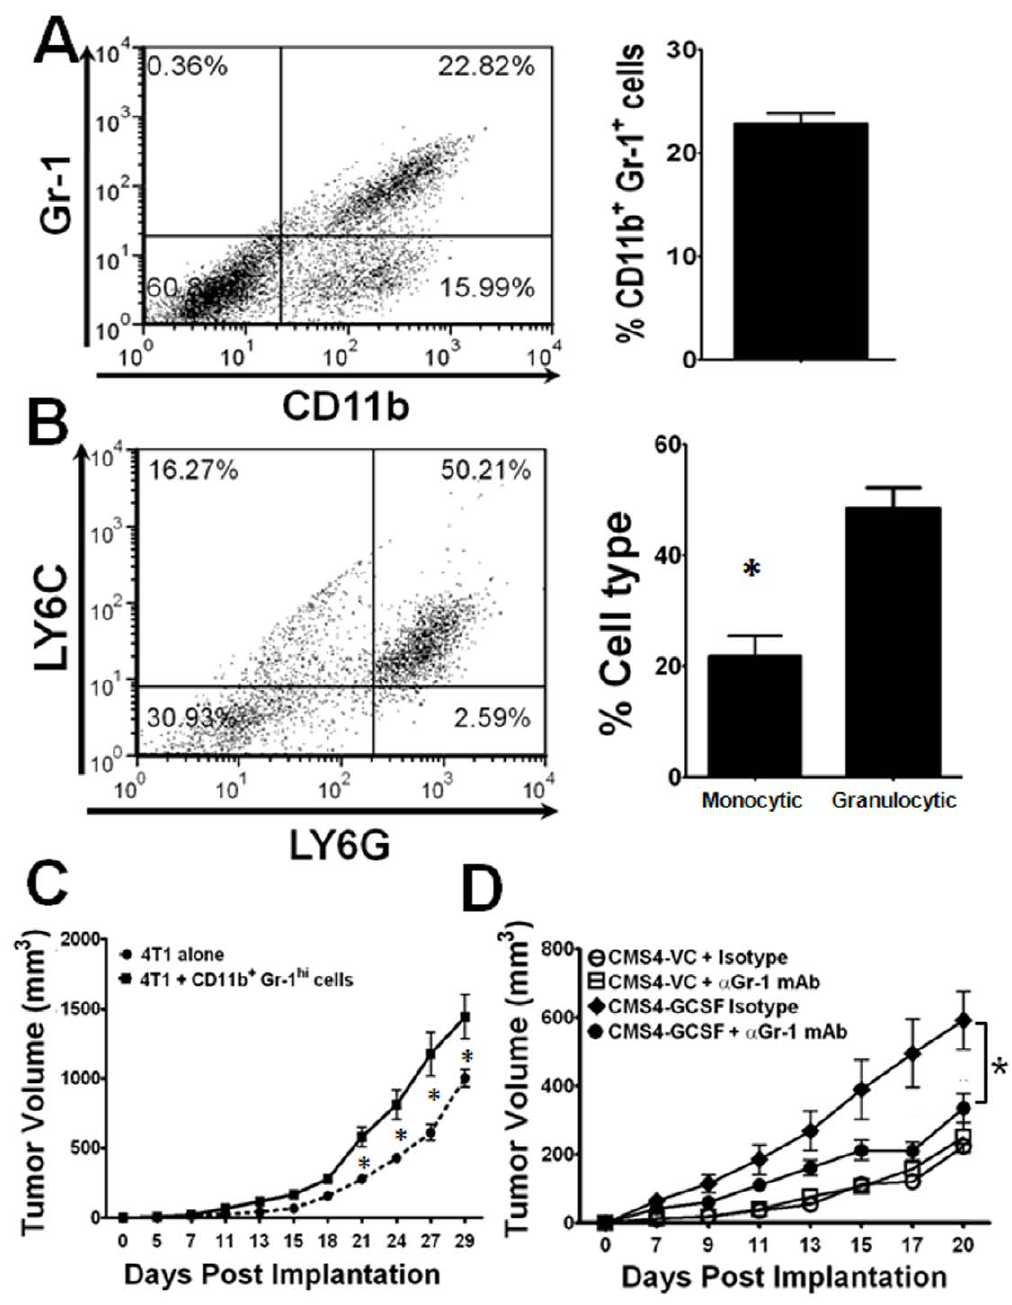
Figure 8. CD11b + Gr-1 hi cells from G-CSF-treated mice are pro-tumorigenic. Tumor tissue was recovered from individual 4T1 tumor-bearing BALB/c mice, enzymatically digested and then analyzed by flow cytometry for the percentages of the global MDSC response (panel A ), as well as the granulocytic and monocytic MDSC subsets (panel B ) as in Fig. 2. The enzyme cocktail contained DNase I (30 U/ml), collagenase A (1 mg/ml) and hyaluronidase (0.1 mg/ml, Sigma). Data are representative of 4 separate mice, and the differences between both granulocytic and monocytic MDSC subsets were significant (* P , 0.003). Compilation of data points in panels A and B are shown on the right side of each dot plot. ( C ) CD11b + Gr-1 + cells were isolated from the spleens of G-CSF-treated BALB/c mice (see Fig. 2 for treatment) by two-color flow cytometric sorting. The sort focused on the recovery of CD11b + Gr-1 high cells, consistent with the granulocytic fraction. 4T1 tumor cells (5 6 10 4 /mouse) were then injected alone or admixed with these CD11b + Gr-1 high cells (2.5 6 10 4 /mouse) just prior to orthotopic tumor challenge (2:1 ratio of tumor:myeloid population). Tumor growth data expressed as the mean 6 SEM of 4 mice/group. * Indicates significant P -values , 0.05 between the two groups at the indicated time points. ( D ) Vector control or G-CSF expressing CMS4 cells were implanted into BALB/c mice, as in Fig. 6. When tumors became palpable, all mice were treated with anti- Gr-1 mAb or rat IgG control. Data are reported as mean 6 SEM of 5 mice per group ( P , 0.04 for the various comparisons at day 20).